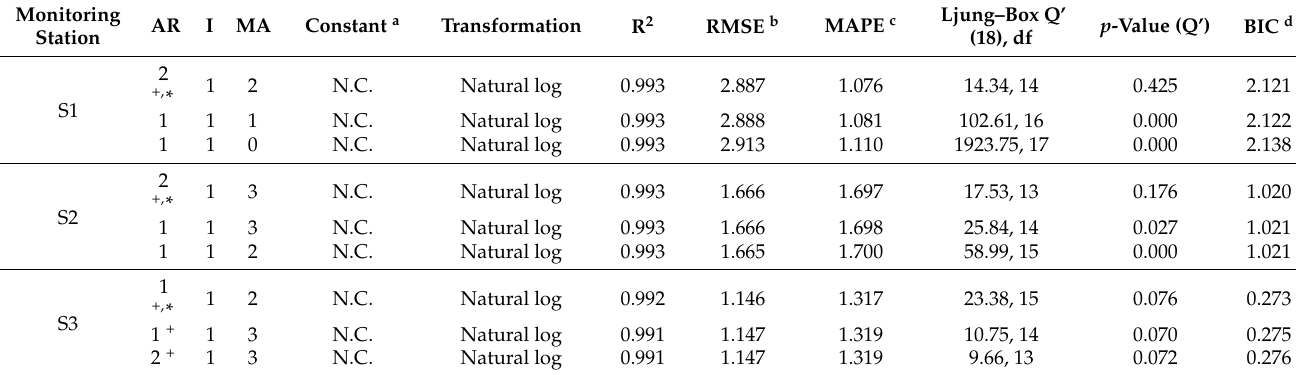
Table 3. ARIMA models for daily PM 10 concentrations (DPM 10